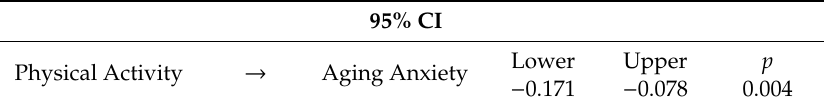
Table 10. Statistical significance of mediating e ff ect.